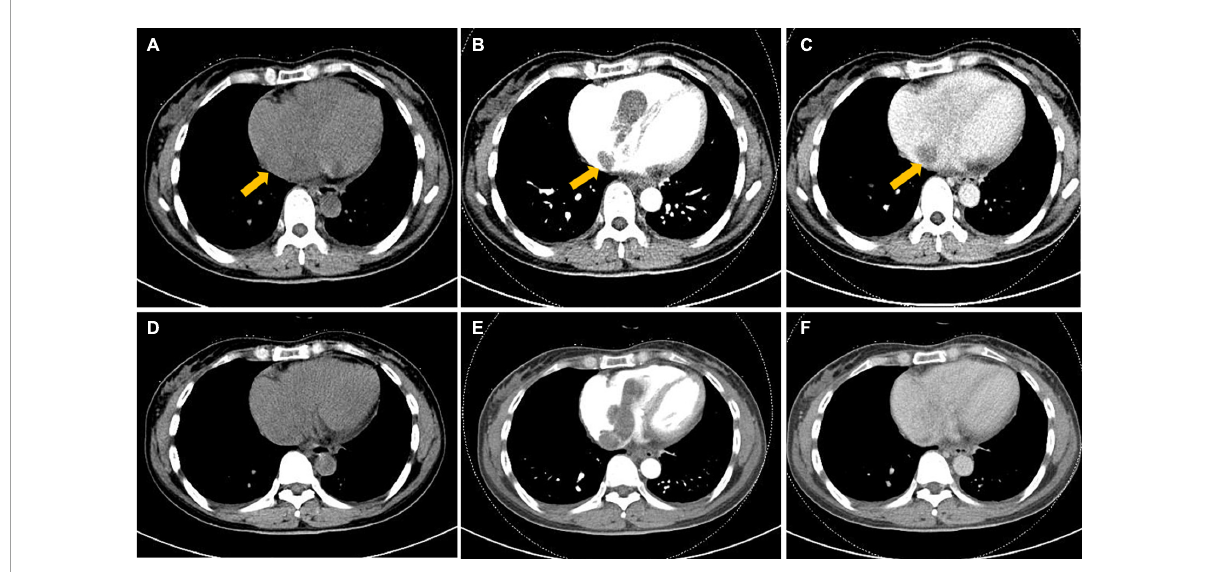
FIGURE2 Axial computed tomography (CT) image of the heart. (A–F) Hypoattenuating filling defect located within the right atrium across the tricuspid valve into the right ventricle. Intracardiac lesions demonstrated mainly moderate progressive enhancement, with localized non-enhancing necrotic areas (arrow) on contrast-enhanced CT. (A,D) Unenhanced phase image. (B,E) Arterial phase of contrast enhancement image. (C,F) Portal phase of contrast enhancement image.